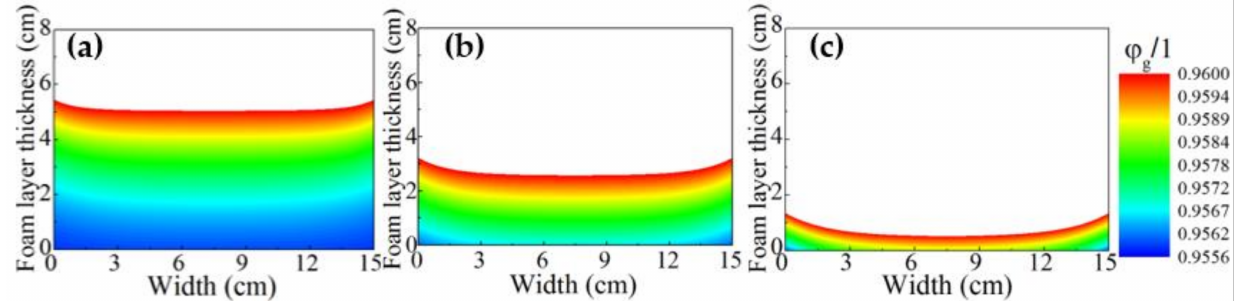
Figure 5. Contour of the gas phase volume fraction in the foam layer under the typical operating conditions at different heating times. ( a ) t = 4 min, ( b ) t = 8 min, and ( c ) t = 12